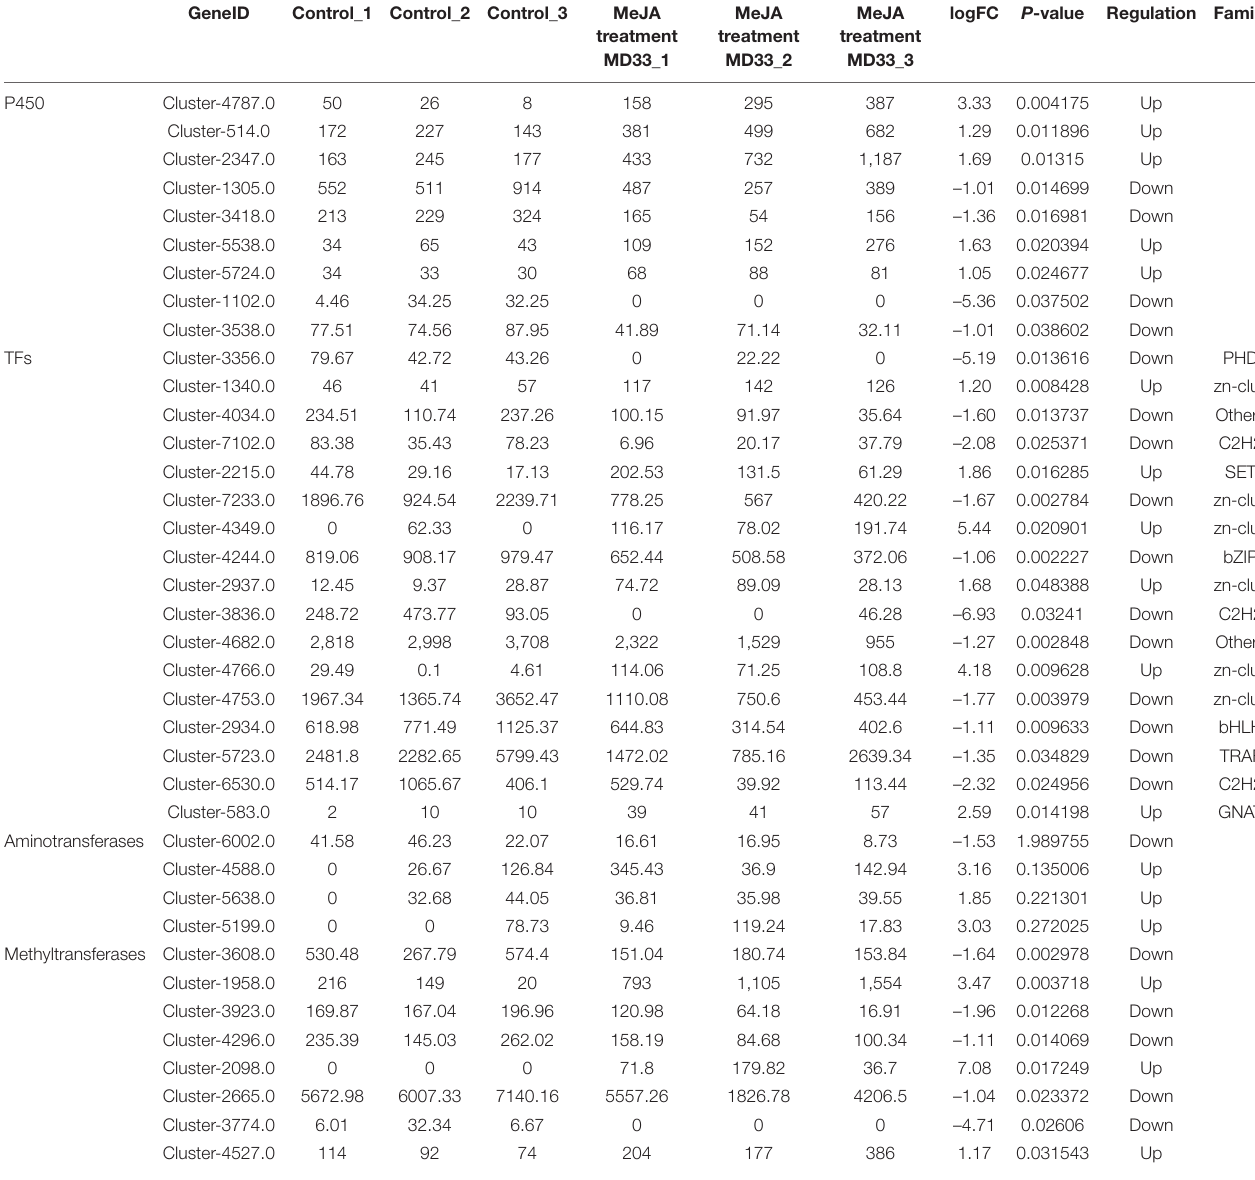
TABLE 1 | The comparation of P450, TFs, aminotransferases and methyltransferases between control and MeJA treatment MD33